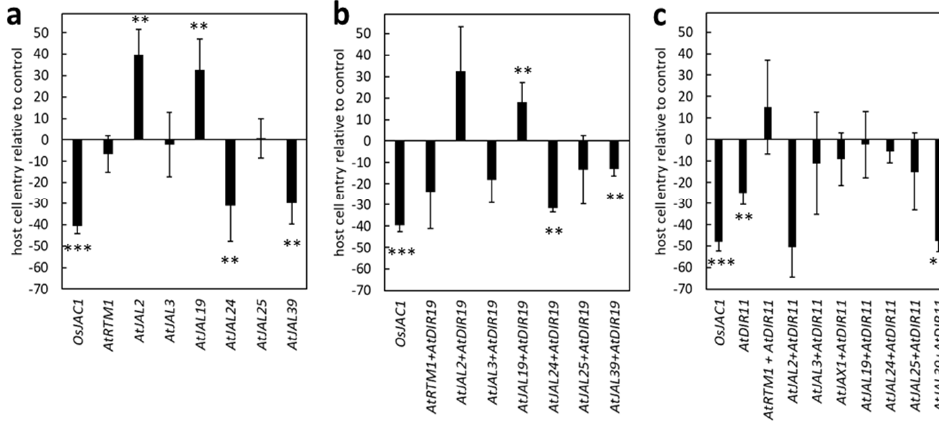
Figure 4. Transient expression of Arabidopsis DIR and JRL candidate genes. Primary leaves of barley were transiently transformed with the constructs as indicated. JRL-containing genes were expressed either alone ( a ), together with AtDIR19 ( b ), or with AtDIR11 ( c ). The effect of transient gene expression on the penetration success of Bgh was evaluated at 48 h p.i. Calculation of host cell entry rates and statistically analyses were performed in analogy to Figure 2. Significant differences ( P = 0.01) were determined using the Mann–Whitney rank sum test and are indicated by asterisks ( P < 0.01: **; P < 0.001: ***). The values presented are transformed to enable direct visualization of increased or reduced penetration success of Bgh . The bars represent the mean values of at least three experiments with a total of 50 to 300 interaction sites evaluated on three leaves ( n = 3) ± standard deviation.